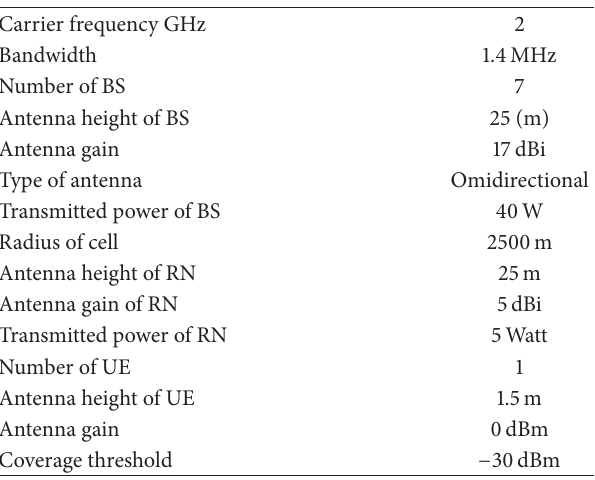
Table 1: Simulation parameters.